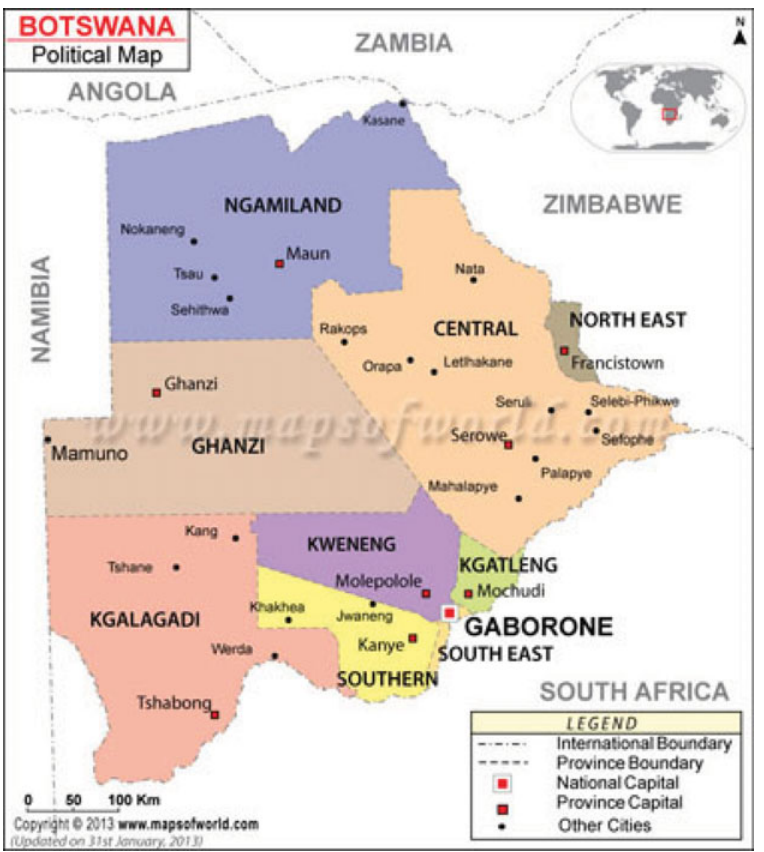
(Colour online) Map of Botswana showing the different